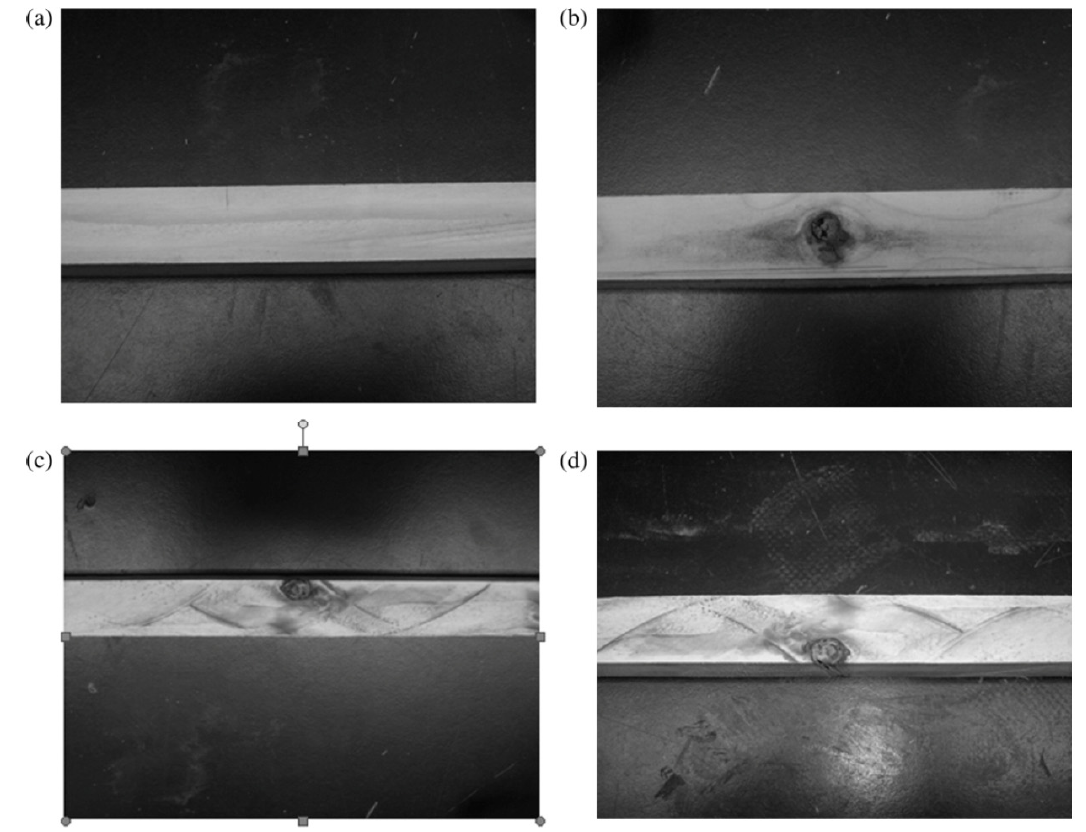
Figure 12. Photographs of four 25 × 25 × 206 mm Douglas Fir beam bending specimens. ( a ) Clear wood; ( b ) knot mid-height of the face; ( c ) knot subjected to compression; ( d ) knot subjected to tension. From [87].